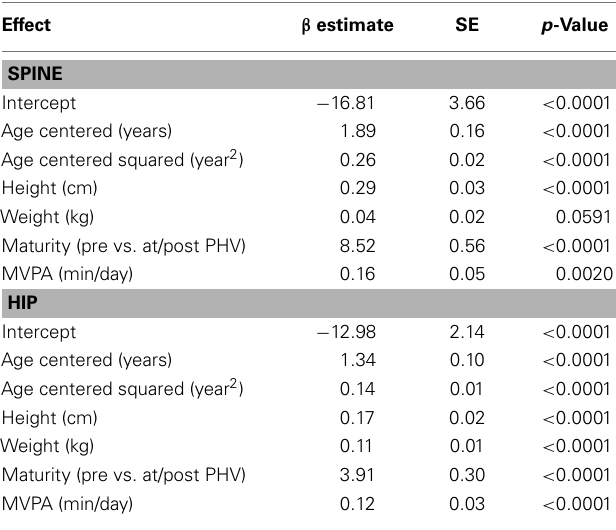
Table 2 | Fixed-effects of the multi-level models examining the association of MVPA with spine and hip BMC in males .